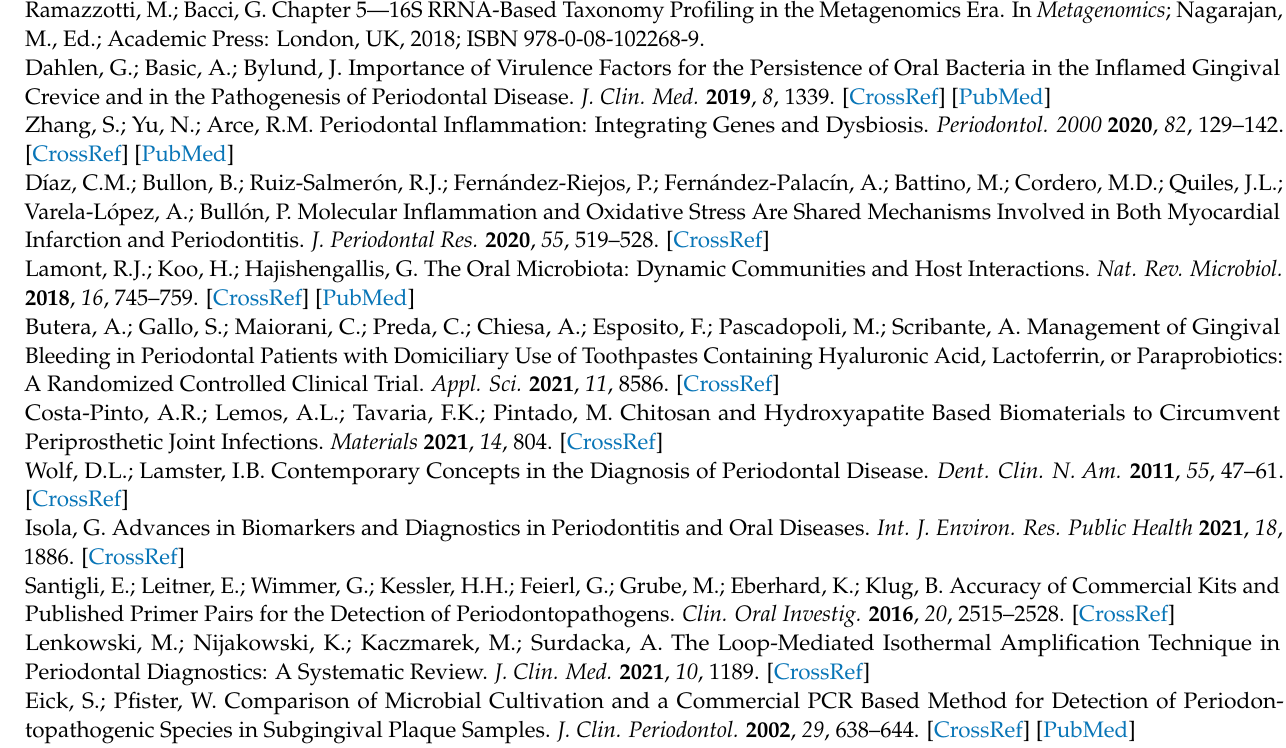
Table S2: The sequences of PCR primers; Table S3: The detailed reagents for LAMP; Table S4: The detailed reagents for PCR; Table S5: The detailed reagents for qPCR; Figure S1: Fluorescent curves of LAMP; Figure S2: Fluorescent curves of